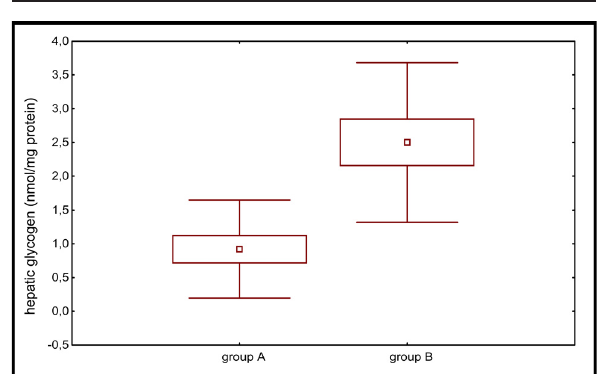
FIGURE 4 - Graphic presentation of hepatic glycogen tissue level determined in animals of group A (90 minutes of ischemia and 15 minutes of reperfusion) and group B (sham operation). The comparison showed a significant difference